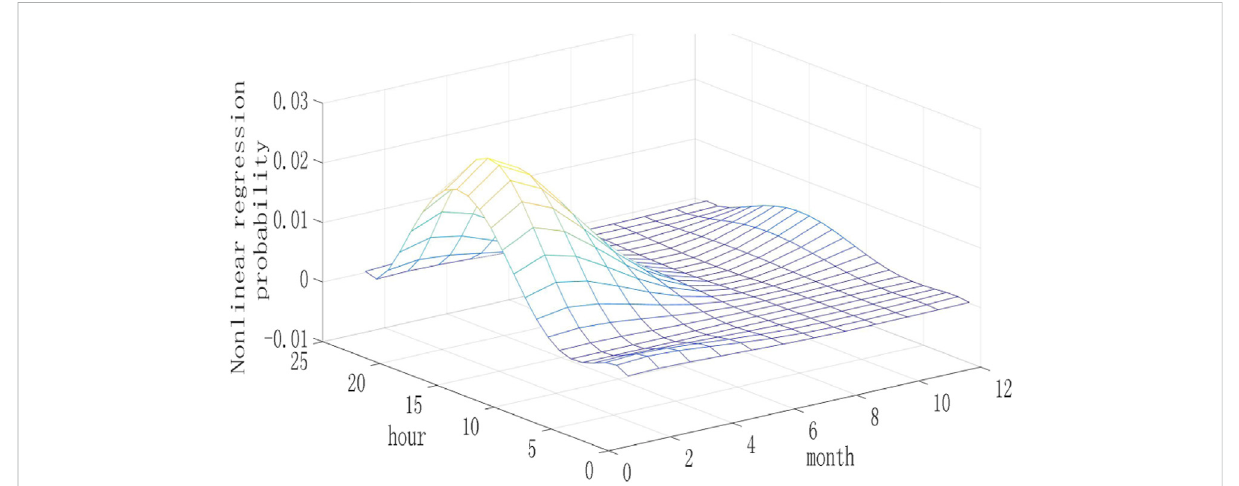
FIGURE 9 Time probability of wild fi res.